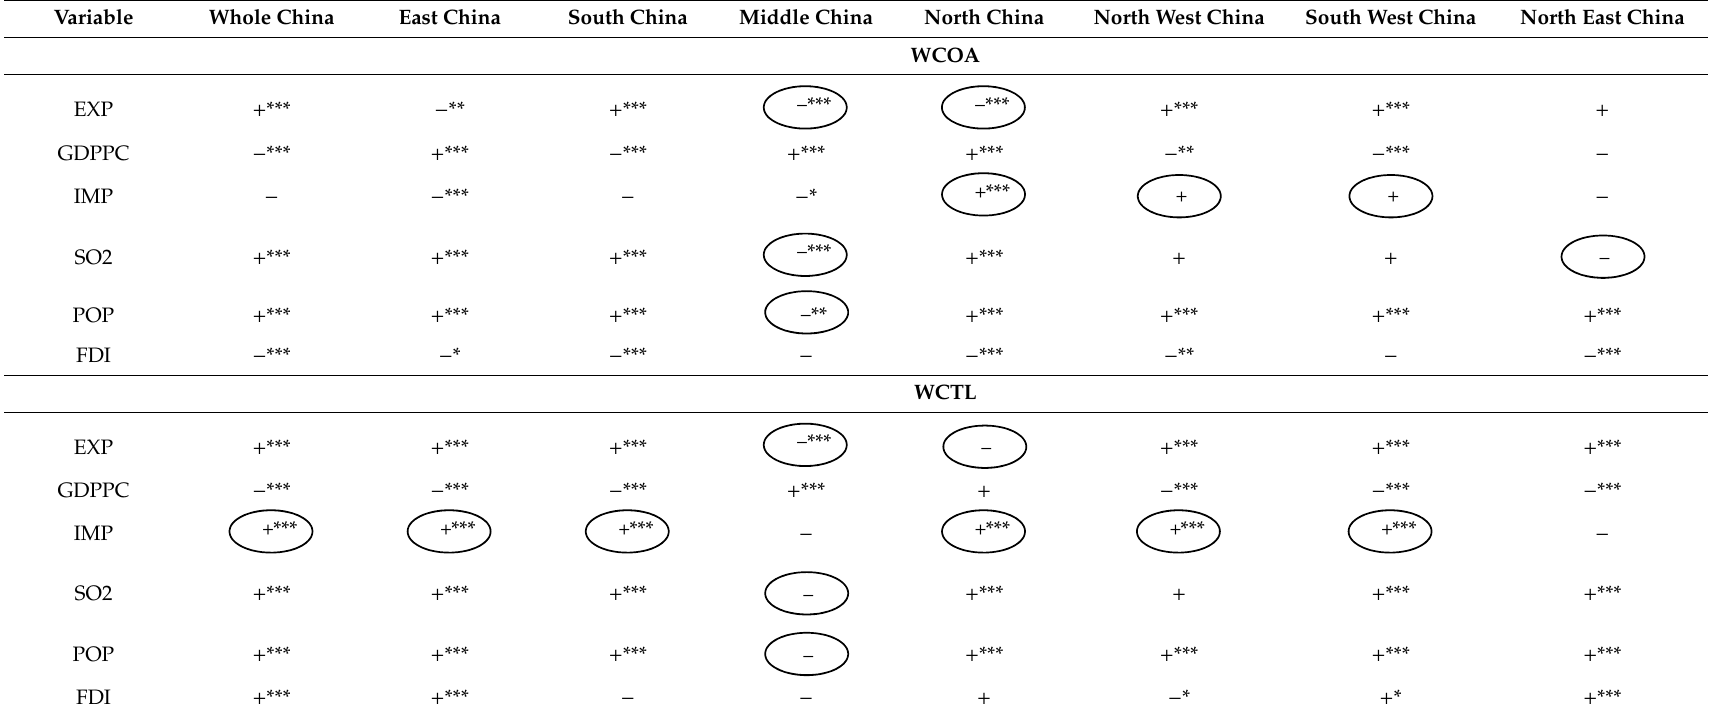
Table 8. FMOLS (Fully modified ordinary least squares) estimates and the sign comparison—actual signs.